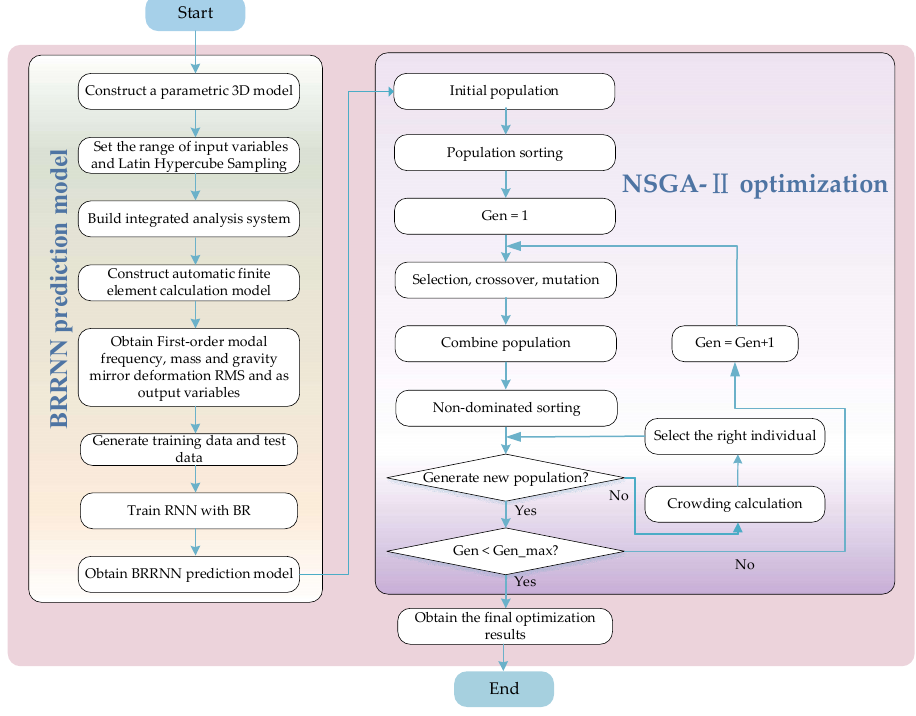
Figure 7. Reflector optimization design